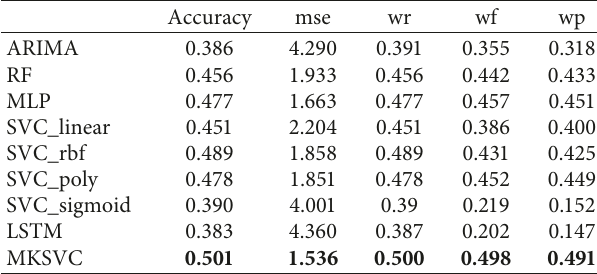
Table 12: Performance comparison for predicting the next hour’s PM2.5 IAQL in Beijing.